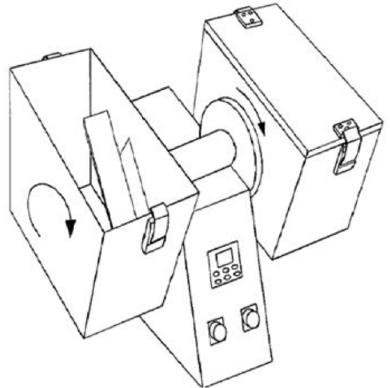
Figure 4. Mechanical durability determination station [48].